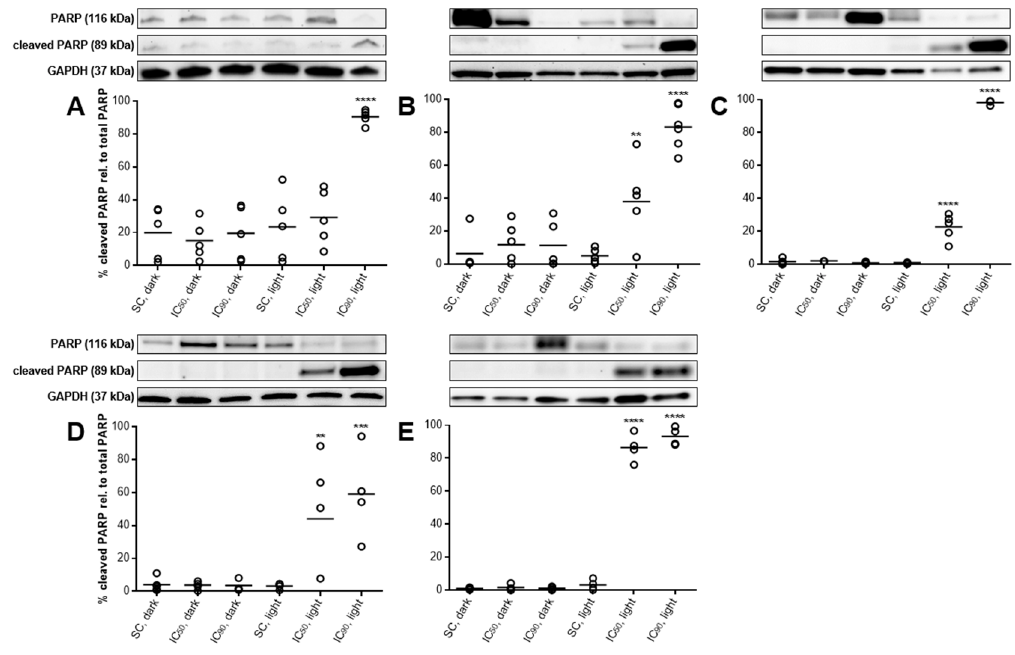
Figure 7. Poly(ADP-ribose) polymerase (PARP) cleavage in A-427 ( A ), BHY ( B ), KYSE-70 ( C ), RT-4 ( D ), and SISO ( E ) cells after mTHPC-PDT. Cells were treated with either solvent (SC) or equitoxic concentrations (IC 50 or IC 90 in Table 1) of mTHPC between 0.02–0.3 µM, illuminated with 1.8 J/cm 2 or left in the dark, and total protein extracts were harvested 24 h after illumination and western blotting performed. Representative blots are shown and the % cleaved PARP relative to PARP was evaluated by densitometric analysis. GAPDH was used as a loading control. Data presented as dot plots from at least three independent experiments. Solvent-treated, non-illuminated cells served as the reference group. (** p < 0.01; *** p < 0.001; **** p < 0.0001).